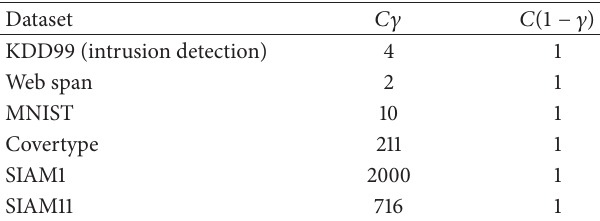
Table 2: Cost-sensitive parameters of three algorithms using CSVM on 6 datasets.